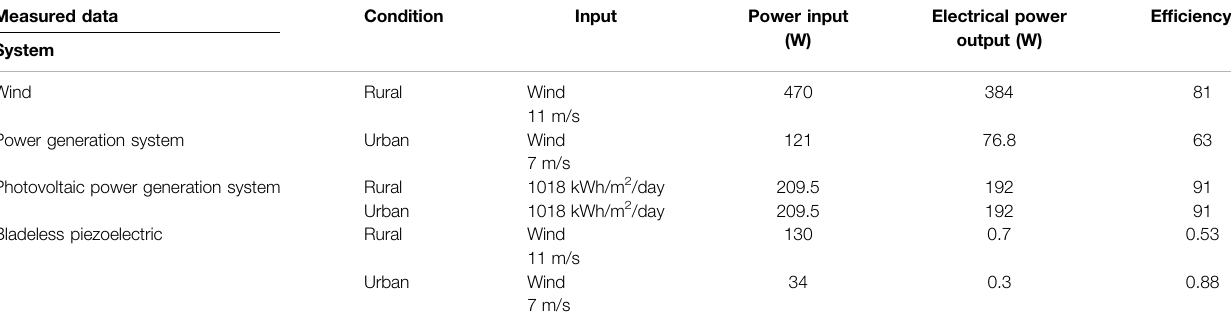
TABLE 1 | Performance evaluation of the developed hybrid power generation